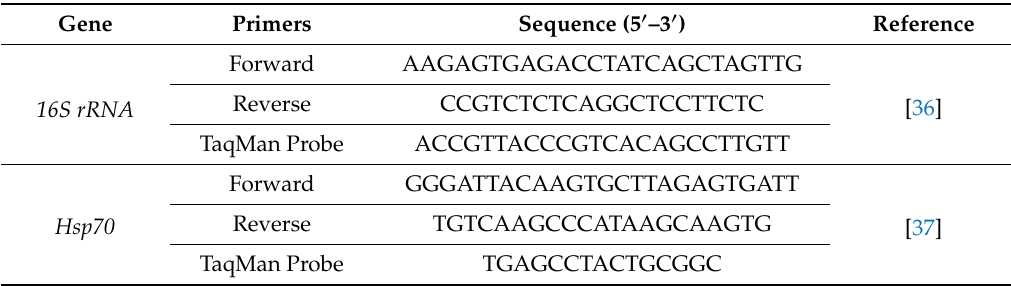
Table 1. Primer sequences used for the qPCR analysis with the Hsp70 and 16S rRNA genes and TaqMan